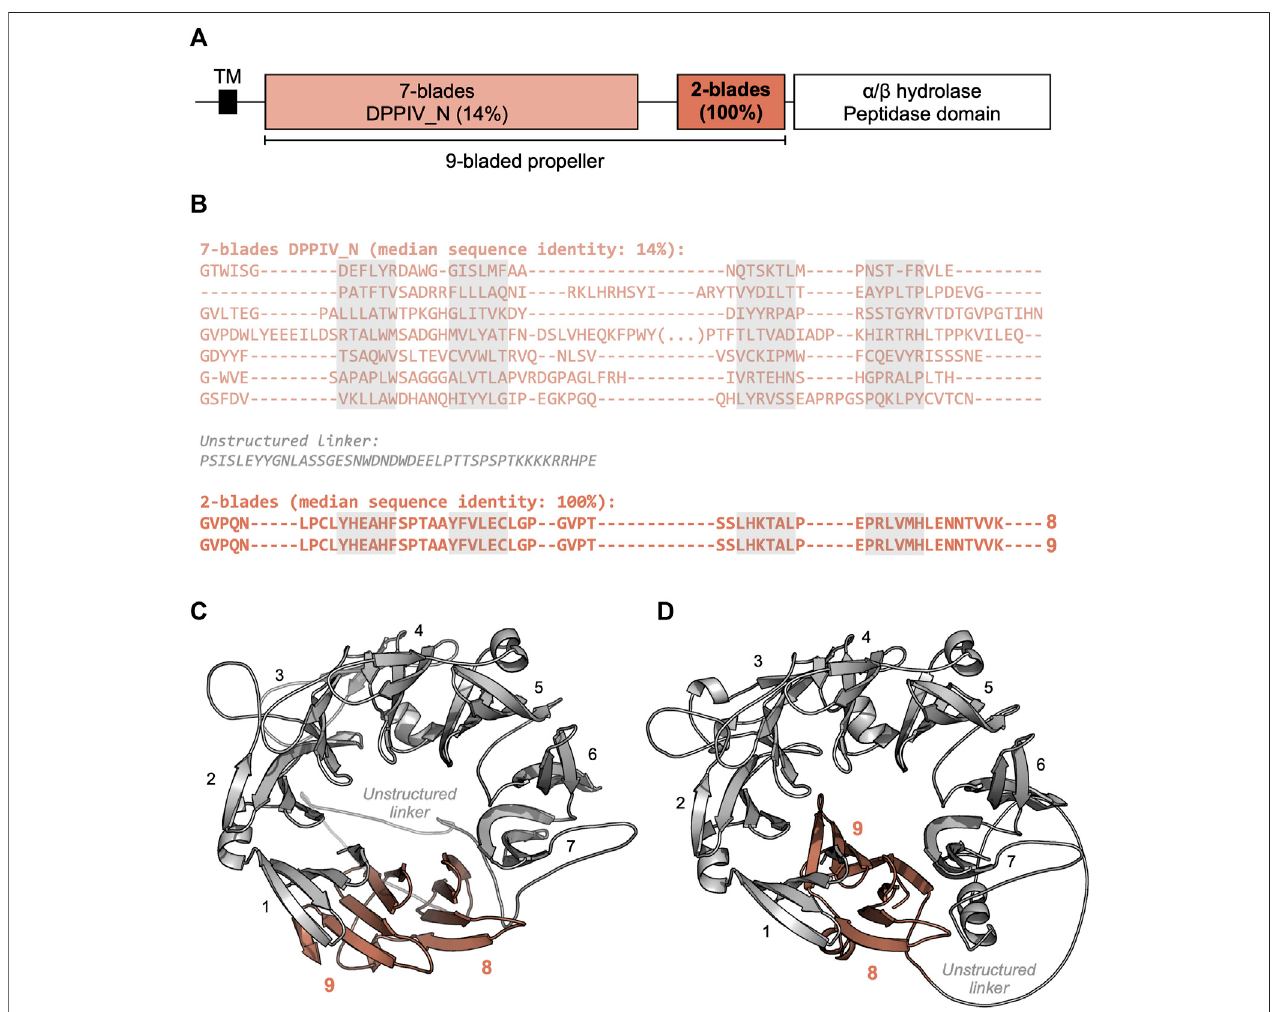
FIGURE 5 | The locally highly repetitive β -propeller of Bombyx mandarina inactive dipeptidyl peptidase 10 (DPPY) (XP_028029463.1). (A) Predicted domain composition of the full-length DPPY sequence. (B) Annotated β -propeller sequence, highlighting the two highly identical, consecutive blades. β -propeller blade sequences were aligned with Promals3D (Pei and Grishin, 2014) based on their predicted structure. The individual strands in each β -propeller blade are highlighted in grey. (C) Three-dimensional model of the β -propeller region, predicted with ColabFold MMseqs protocol as of August 2021 (Mirdita et al., 2021) (QMEANDisCo Global (Studer et al., 2020) score of 0.59 ± 0.05, average pLDDT (Jumper et al., 2021) of 82.9). (D) Three-dimensional model of the β -propeller region, predicted with AlphaFold v2.1.2 (Jumper et al., 2021) (QMEANDisCo Global (Studer et al., 2020) score of 0.62 ± 0.05, average pLDDT (Jumper et al., 2021) of 85.3).